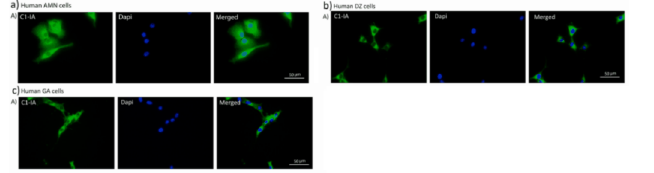
Fig 2. Demonstration of C1-IA at the protein expression level in human glioblastoma cells. The antibody bindingseems to be localizedto the cell membraneand cytoplasm.